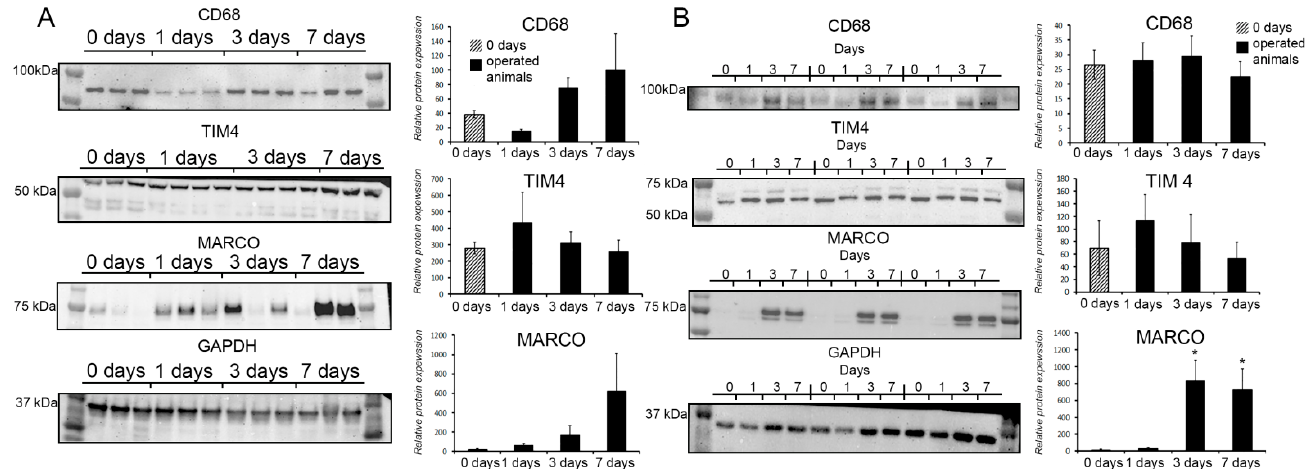
Figure 4. Evaluation of the content CD68, TIM4, and MARCO proteins in tissues ( A ) and isolated macrophages of regenerating liver ( B ) by immunoblotting. Representative images of the signals are shown in panel C, complemented with densitometry; full-size membrane images are given in Supplementary Material Figure S2. The data are presented as means ± standard deviations, with at least five specimens studied for each time point after the resection. *—statistical significance of the differences with 0 h time point ( p < 0.05).